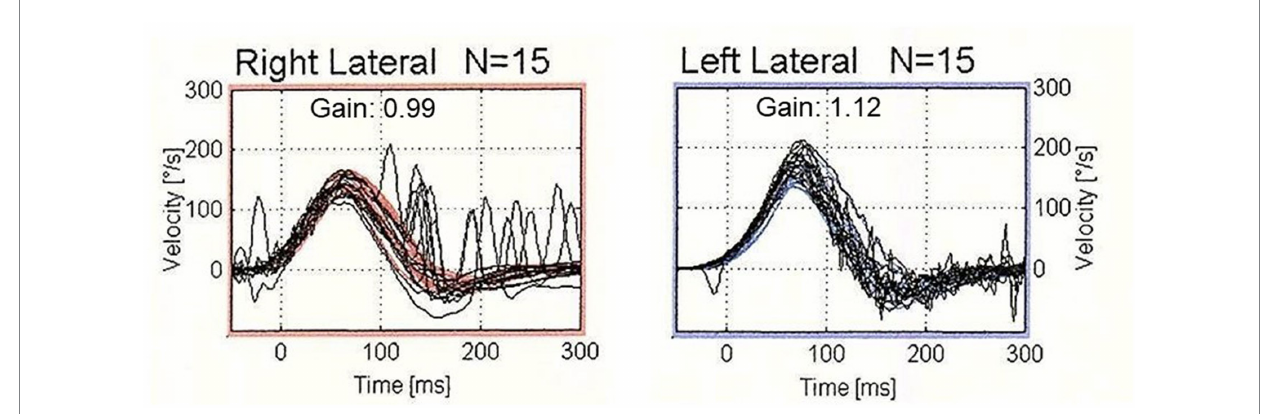
FIGURE 1 The results of video head impulse test (vHIT) in a typical patient who showed corrective saccades (CS) with normal vestibulo-ocular reflex (VOR) gain. vHIT showed normal VOR gain (0.99) with the presence of both covert and overt saccades during head impulses to the right horizontal semicircular canal. On the contralateral side, vHIT showed normal VOR gain (1.12) without